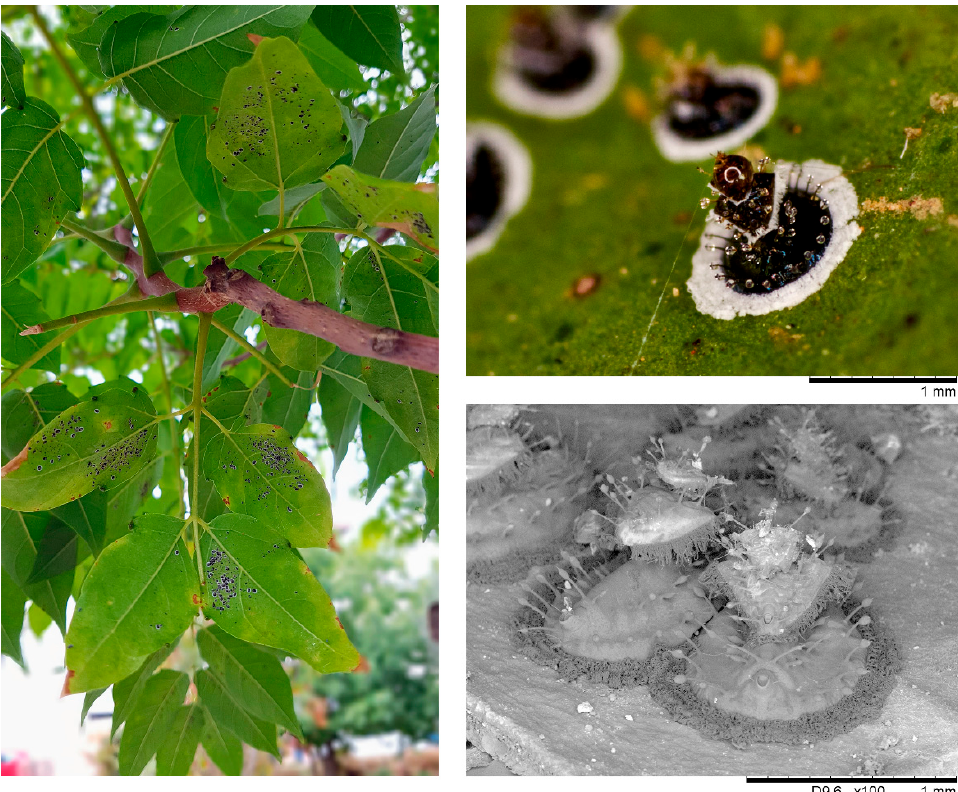
Figure 1. Aleurocanthus spiniferus on Ailanthus altissima leaves in Bari, Apulia region, Italy. Puparia on the underside of the leaves (on the left). Close-up of puparia taken by a photo camera (top right) and a scanning electron microscope (bottom right).